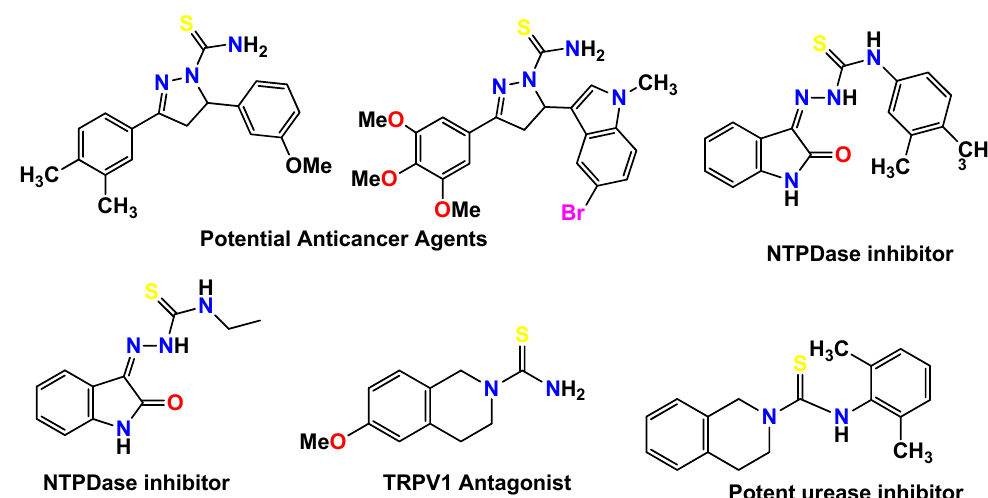
Figure 1. Already-reported bioactive carbothioamide derivatives [23–25].